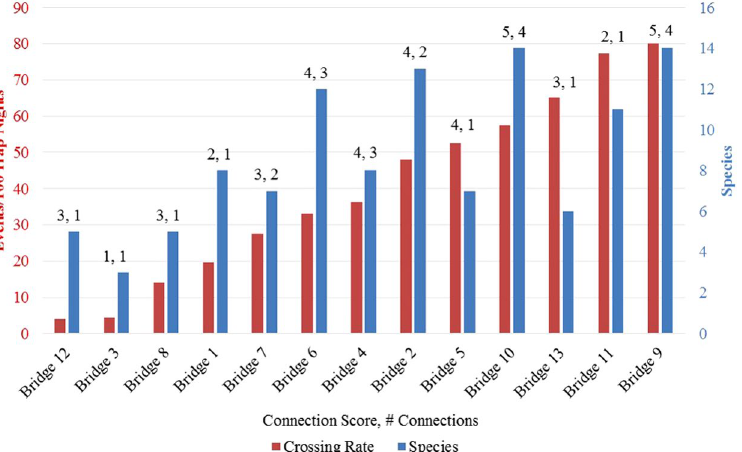
Figure 2. Overall crossing rate for all connections (events/100 trap nights) in each of the 13 natural canopy bridges over the natural gas pipeline clearing, and the total number of species registered in each bridge. The connection score (1–5, see text) and the number of connections (1–4) are indicated above each pair of columns.